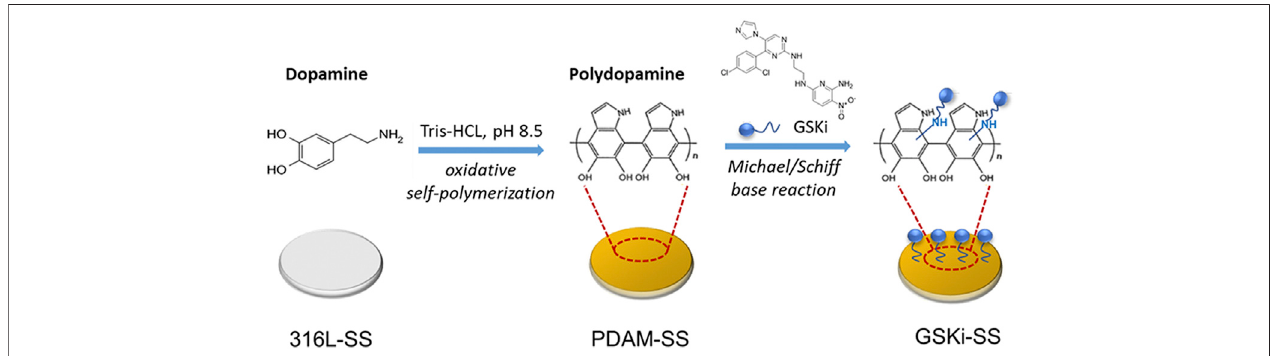
FIGURE 2 | Schematic diagram of the surface modi fi cation of